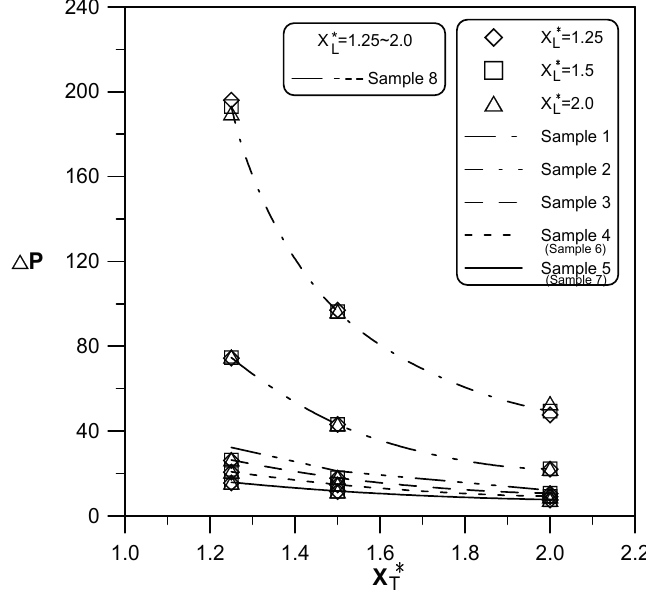
Figure 11. Dimensionless pressure drops for different heat-sink arrays with various X T * and X L *